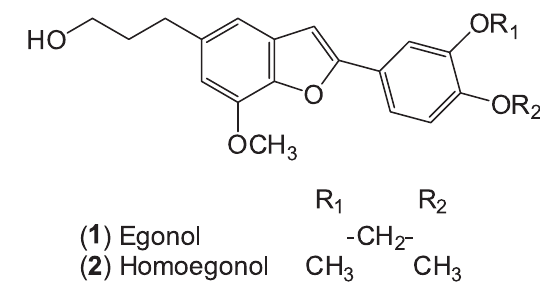
FIGURE 1 - Chemical structures of the compounds